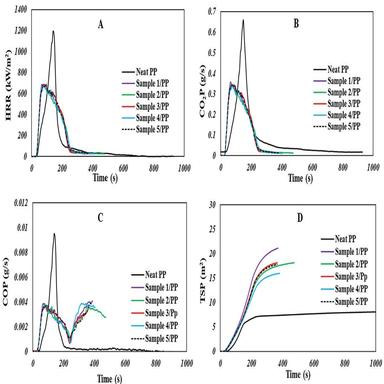
Cone calorimeter results of RH/PP composites obtained by subjecting the samples to radiative heat from a cone heater (A. Heat released rate, HRR; B. Carbon dioxide production rate, CO2P; C. carbon monoxide production rate, COP; D. Total smoke production, TSP). (For interpretation of the references to colour in this figure legend, the reader is referred to the web version of this article.)